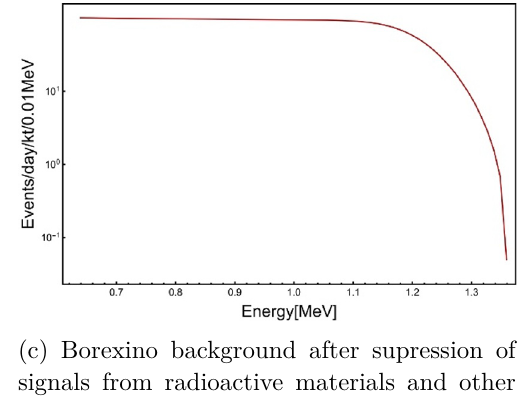
Figure 3. All background signals used in construction of the bounds shown in figure 2. Note that the binning used in each detector is different, and thus the y axis varies from plot to